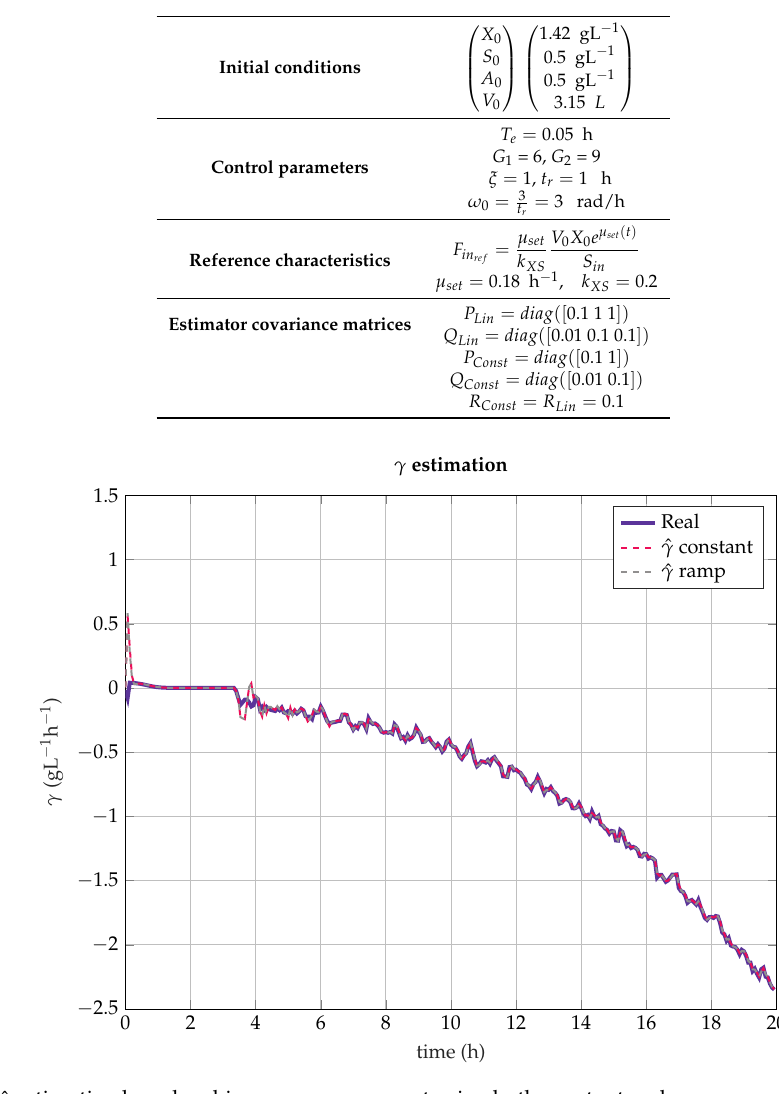
Figure 3. ˆ γ estimation based on biomass measurement using both constant and ramp exogeneous models. Table 6. Root Mean Square error (RMSE) comparison between the constant and ramp exogeneous